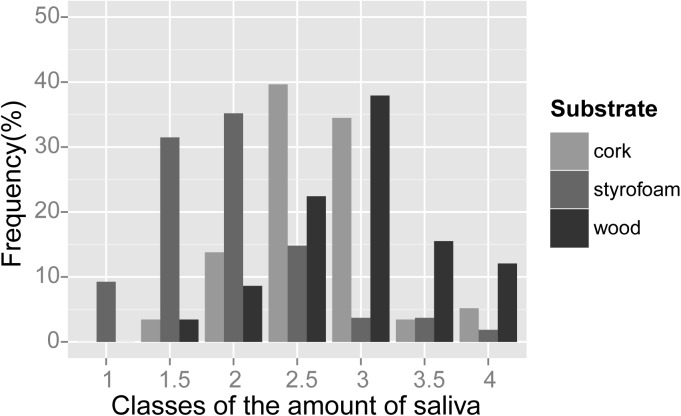
Amount of saliva attached to three types of substrate after dog handling.Bars indicate the distribution of substrates among classes of collected amount of saliva, from absence (class 1) to saturation (class 4). Data from all five experimental sessions are shown. Cork, n = 58; styrofoam, n = 54; wood, n = 58.